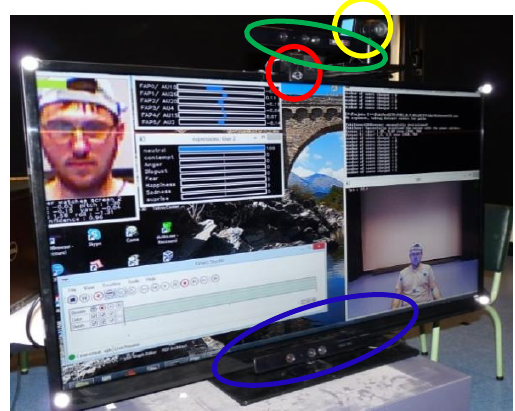
Figure 8. Kinect for KinectSDK in green, Webcam for the facetracker in red, Kinect for 3DCloud in blue, 2D camera synchronized with Qualisys in yellow.